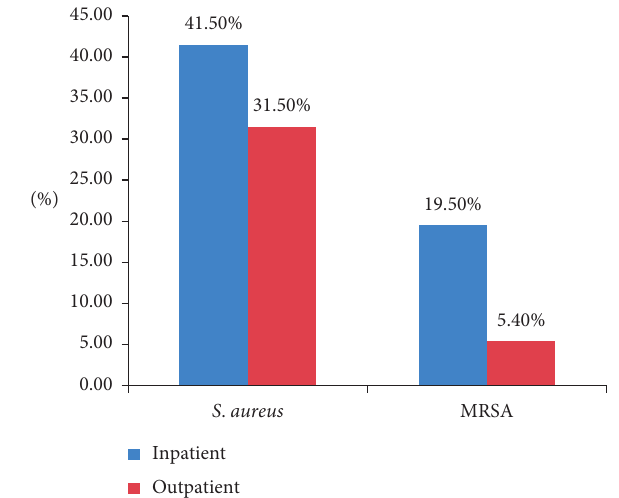
Figure 1: Distribution of S. aureus and MRSA among patients with wound infection in relationship with outpatients and inpatients in Dessie Referral